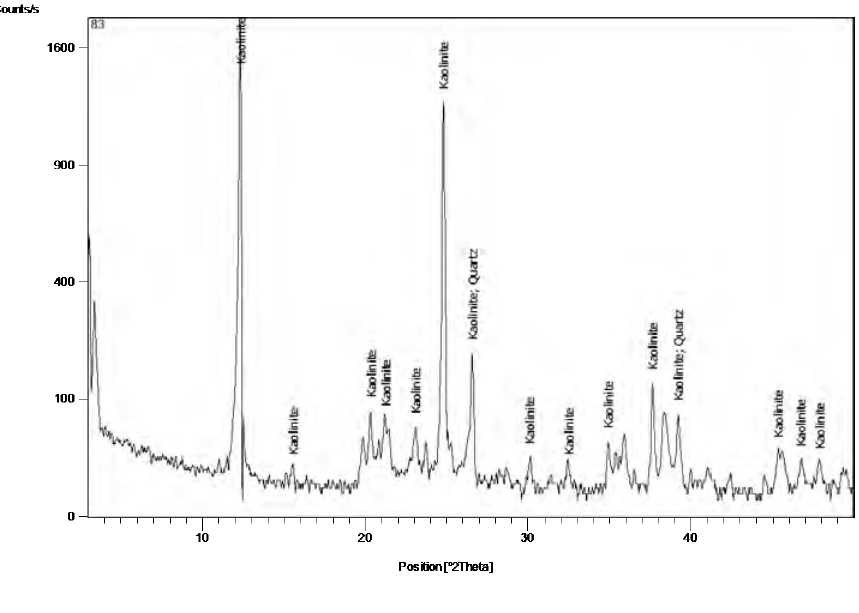
Figure 1. XRD pattern of clay